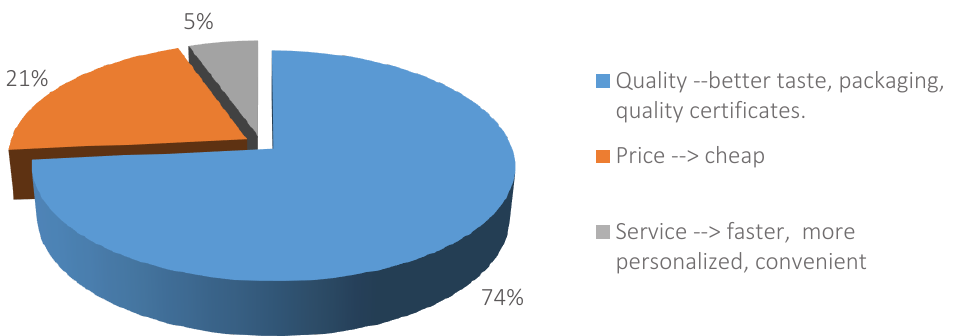
Figure 1. Responses to the question: In general, which of the following factors encourages you to choose one of two similar products?